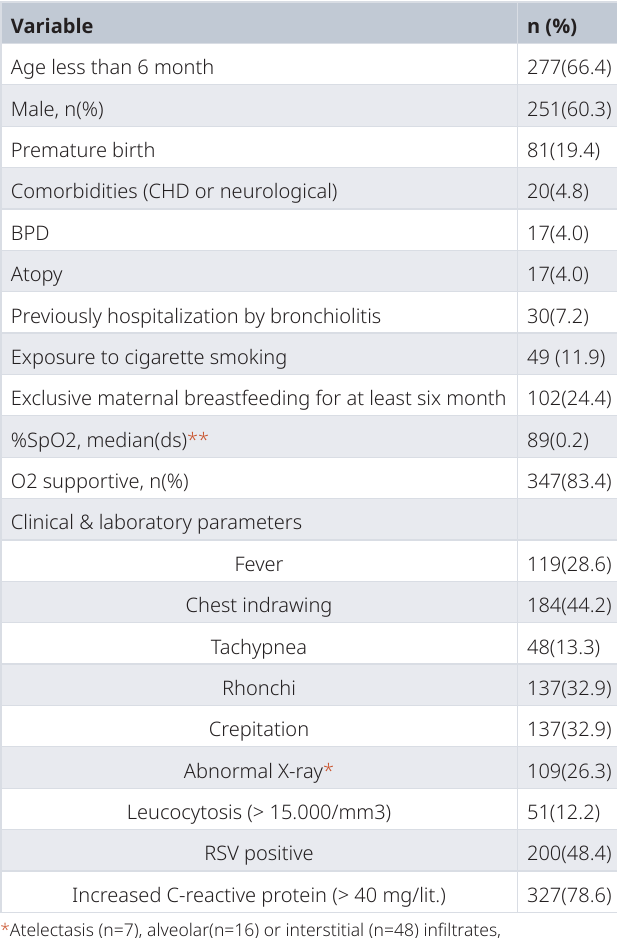
Table 1. Demographic features and clinical information of the patients included in the